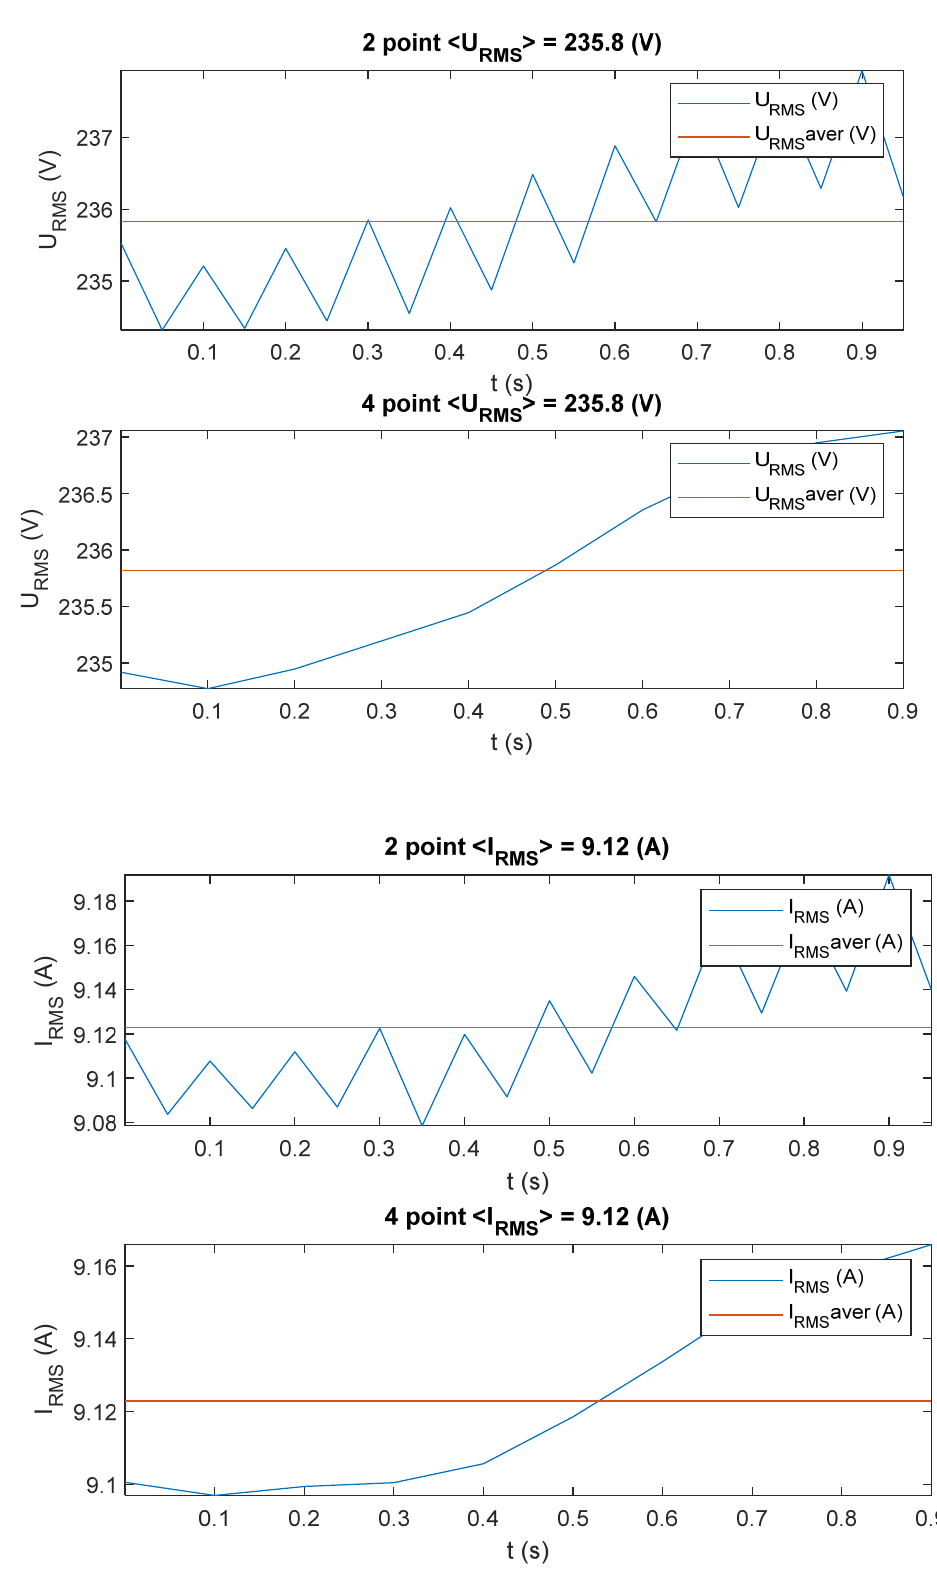
Figure 6. Two-point vs. four-point measurement method of RMS values. U RMS (t), U RMS (average) and I RMS (t), I RMS (average).